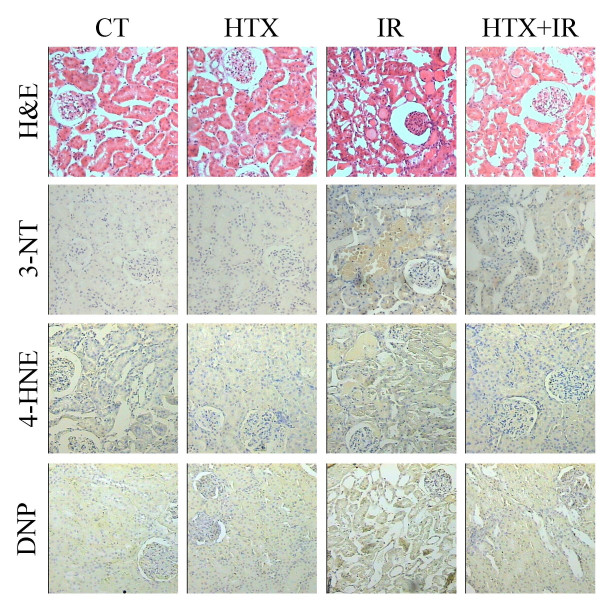
Representative images of histology (H&E) (first row) and immunohistochemical detection of 3-NT (second row), 4-HNE (third row) and DNP (fourth row) in the renal cortex of the four groups of rats studied: Control (CT), thyroidectomized (HTX), ischemia and reperfusion (IR) and HTX+IR (100× magnification).